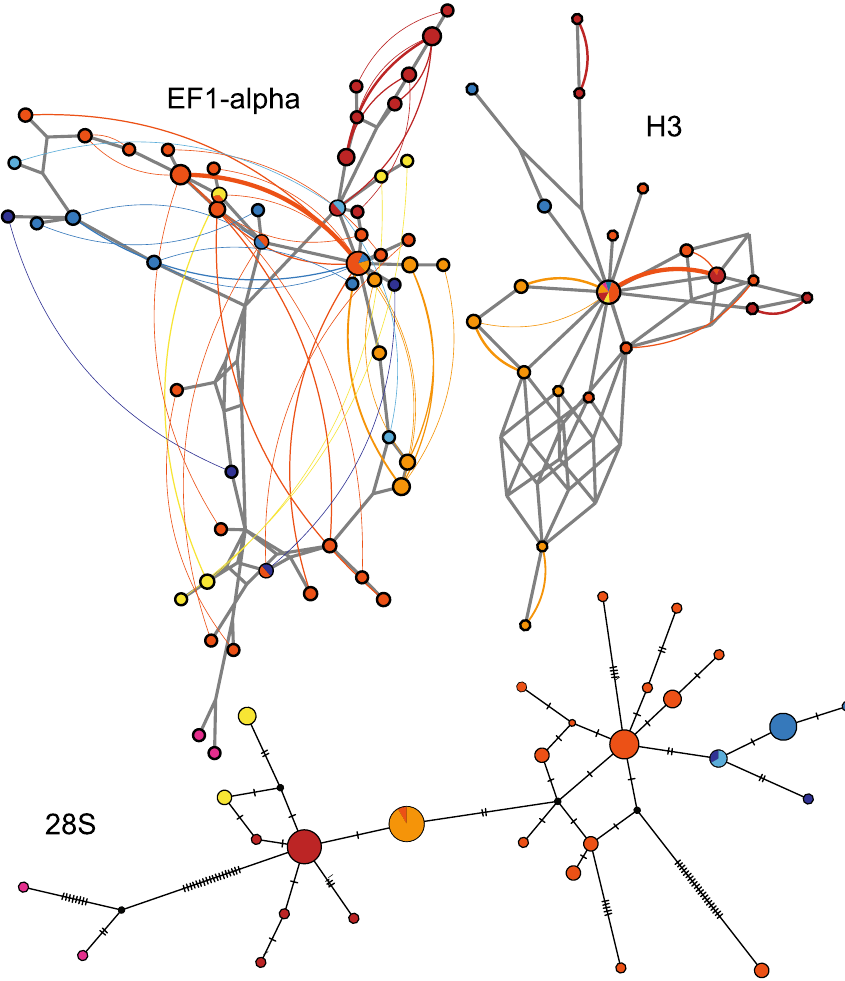
Figure 4. Haplotype networks for nuclear markers based on all G. tatrensis and G. stasiuki sp. nov. sequences. Networks for EF1-alpha and H3 reconstructed with phased haplotypes in haploweb software. 28S haplotype network reconstructed using the median-joining approach. Colours represent MOTUs (see Figs. 1,